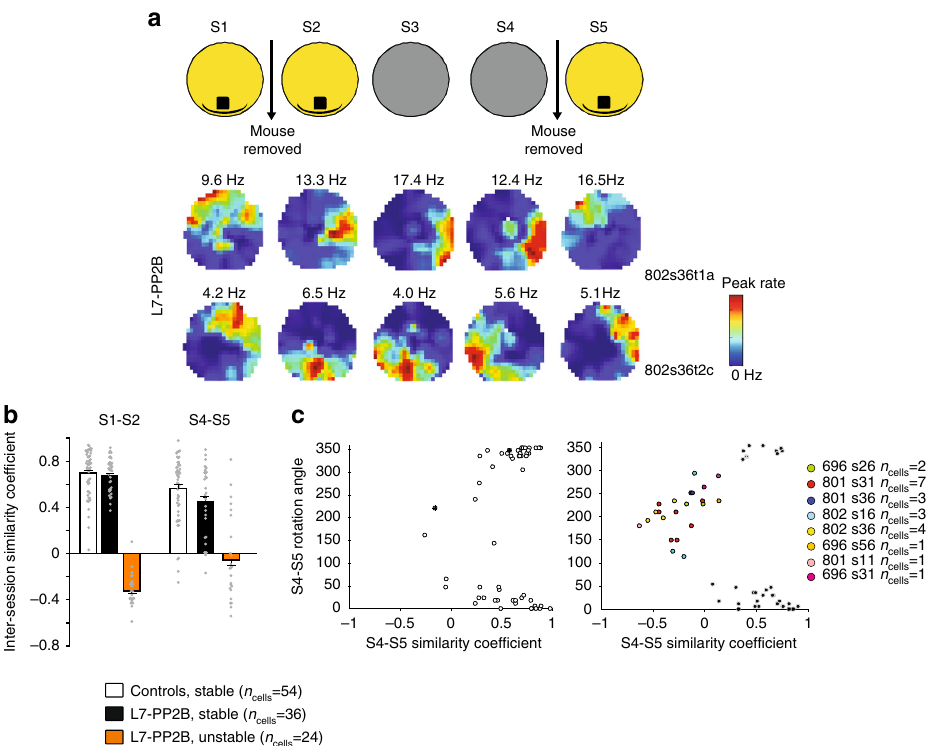
Fig. 4 Instability occurs upon entry in a familiar environment. a Examples of color-coded fi ring maps of two simultaneously recorded L7-PP2B place cells over the fi ve consecutive sessions, for which instability occurred both at S1 – S2 and S4 – S5 transitions. b Barplot showing inter-session similarity coef fi cient for control and L7-PP2B place cells at S1 – S2 and S4 – S5 transitions, i.e., at transitions corresponding to entries into the arena. Cells from stable recordings (white for controls, black for mutants) are separated from cells from unstable recordings identi fi ed at S1 – S2 transition (orange for mutants). In this protocol, no recording showed S1 – S2 instability in control mice. c Instabilities at S4 – S5 transition occurred only in L7-PP2B mice. Scatter plots showing the distribution of place cells from control and L7-PP2B mice according to their S4 – S5 similarity coef fi cient and S4 – S5 rotation angle. Cells from unstable sessions are color-coded, emphasizing the angular coherence of cell ensembles. The few unstable cells observed in the controls come from sessions in which all other simultaneously recorded cells were stable. Error bars represent